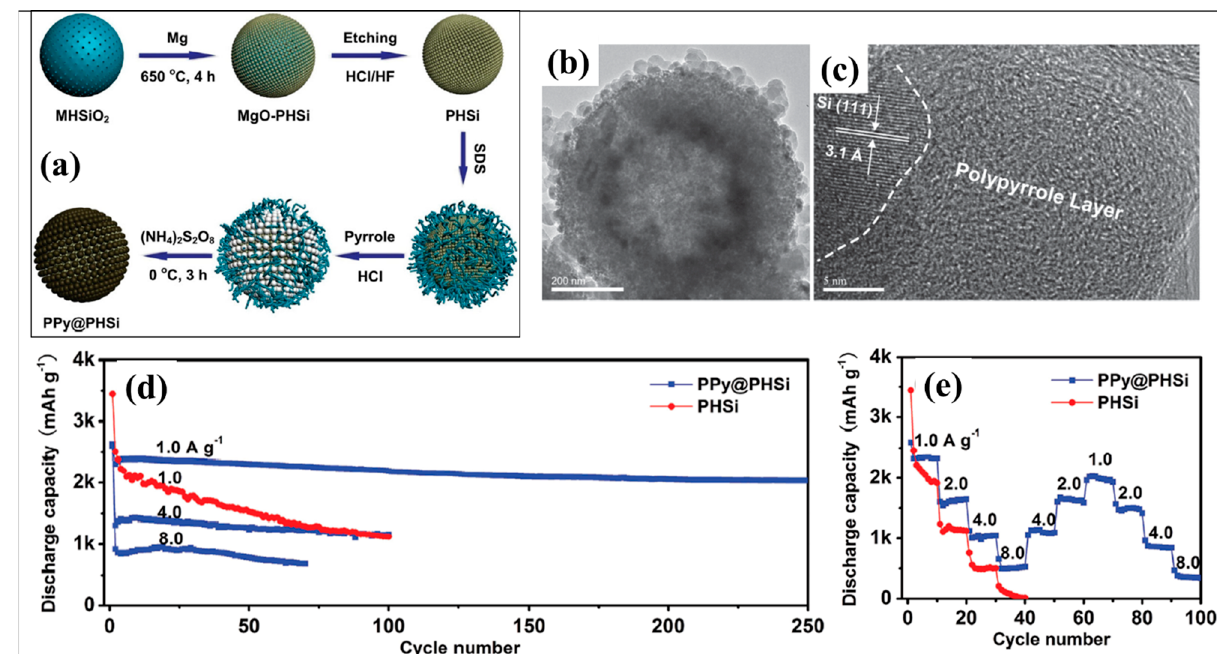
Figure 6. ( a ) Schematic illustration of the fabrication of Si hollow nano-spheres and PPy coating on particles. ( b , c ) Microscopic images of polymer-coated samples. ( d , e ) Electrochemical characterizations of uncoated and coated electrodes. Reproduced from Ref [44] with permission from Wiley.